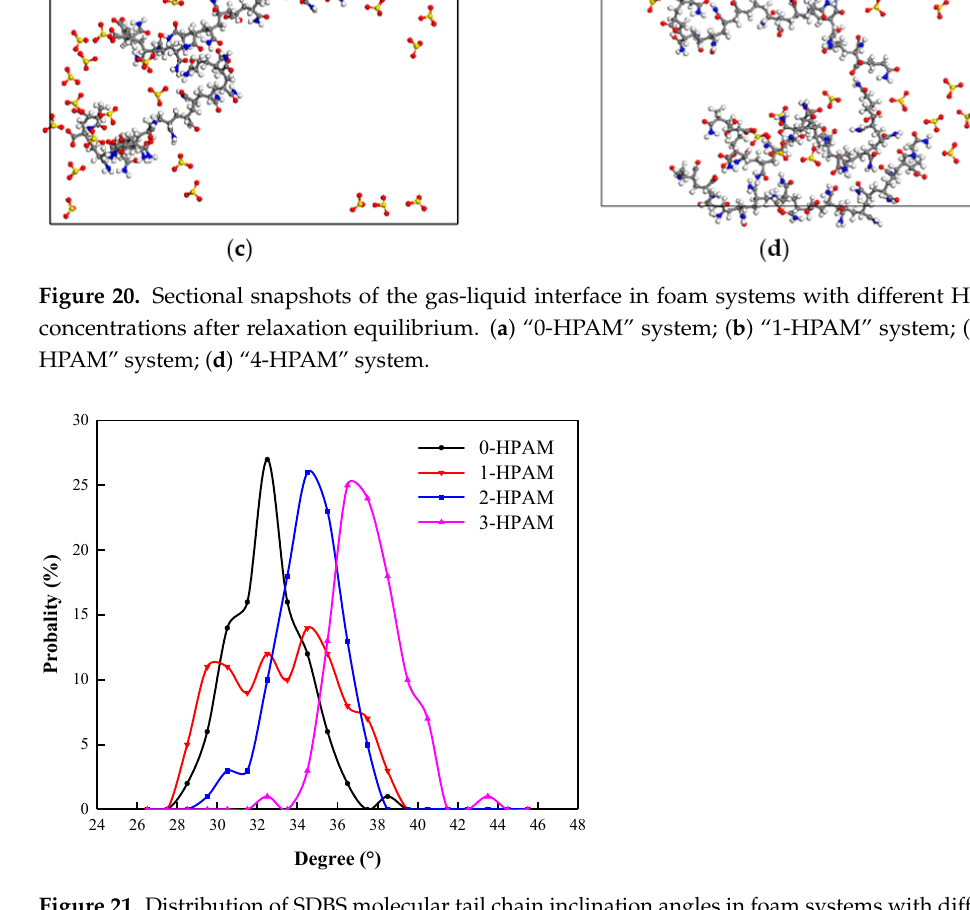
Figure 21. Distribution of SDBS molecular tail chain inclination angles in foam systems with different HPAM concentrations.